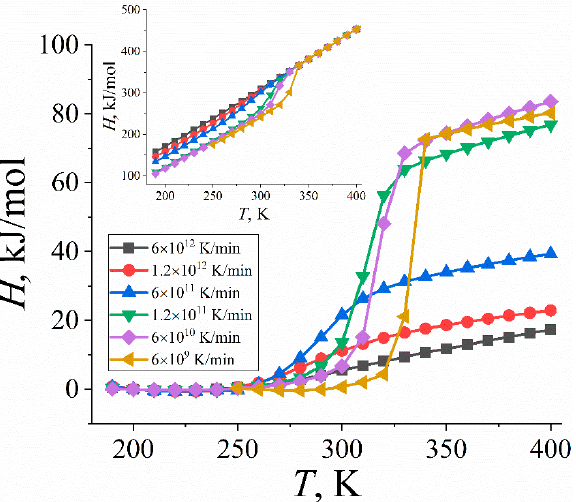
Figure 2. Enthalpy H of n-eicosane samples as a function of temperature T for different cooling rates. The enthalpy was reduced by subtracting the initial linear parts of the H(T) -curves in the low-temperature domain. The inset shows the original H(T)